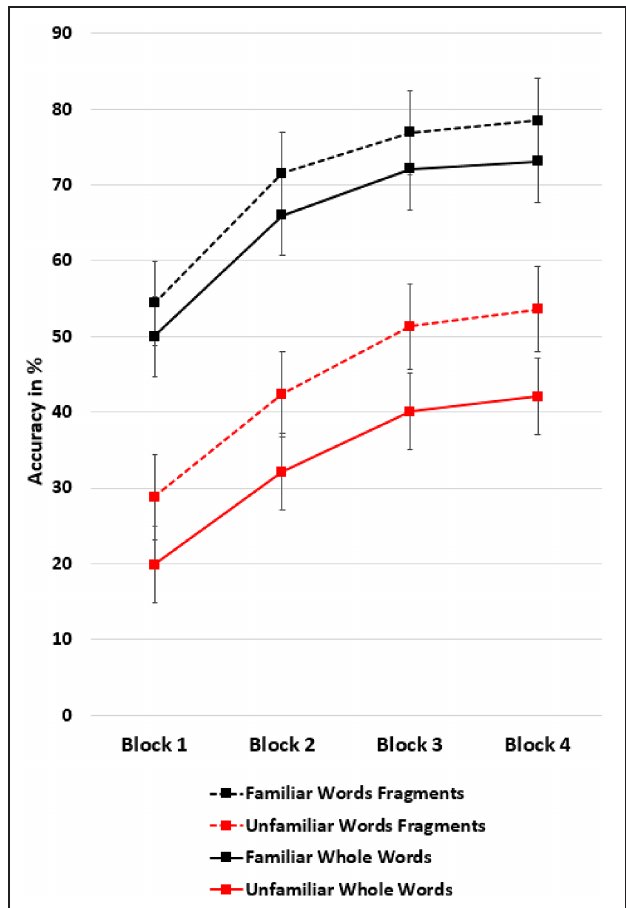
FIGURE 3 | Effect of familiarity. It was significantly more likely that unfamiliar words were recalled as word fragments (letter sequences) than familiar words. Means are controlled for age. Bars denote the